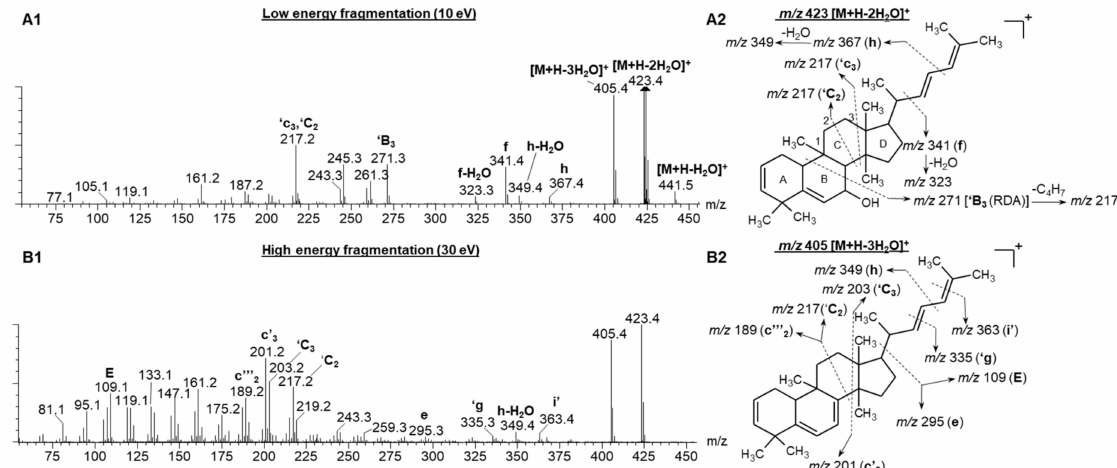
Figure 3. The fragmentation spectra of compound 6 under low ( A1 ) and high ( B1 ) energy CID conditions. ( A2 ) represents the proposed fragmentation pattern of m / z 423 [M + H − 2H 2 O] + under low energy conditions and ( B2 ) illustrates the fragmentation pattern of m / z 405 [M + H − 3H 2 O] + under high energy